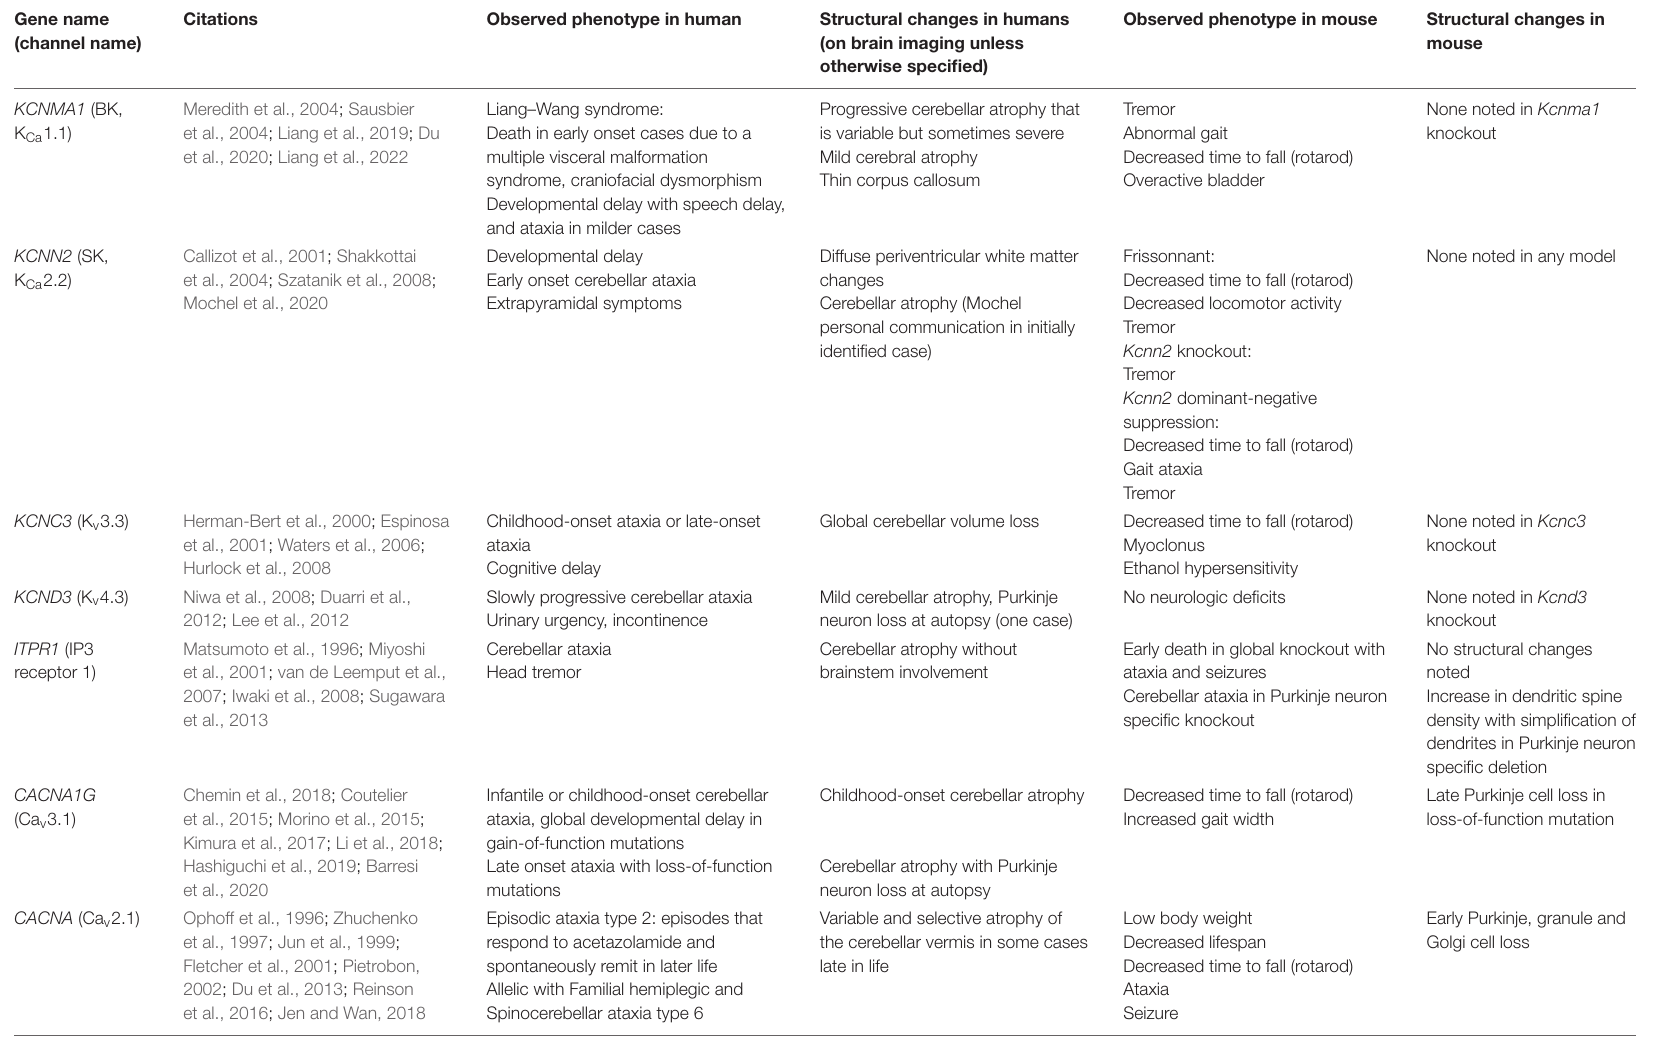
TABLE 1 | Phenotypic and structural alterations in human and mouse ion channel gene loss-of-function